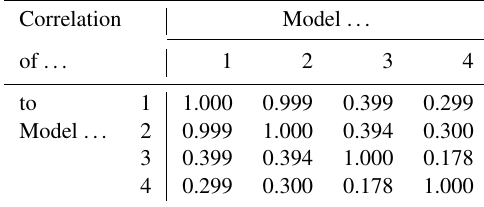
Table 4. Correlation between models. Correlation Model